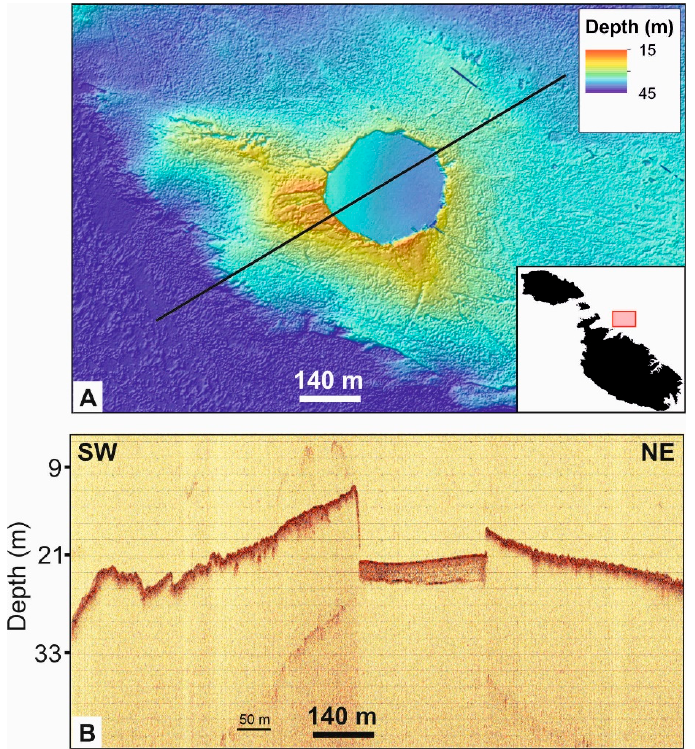
Figure 5. ( A ) Solution subsidence structure located offshore NE Malta (Location in inset). Width of